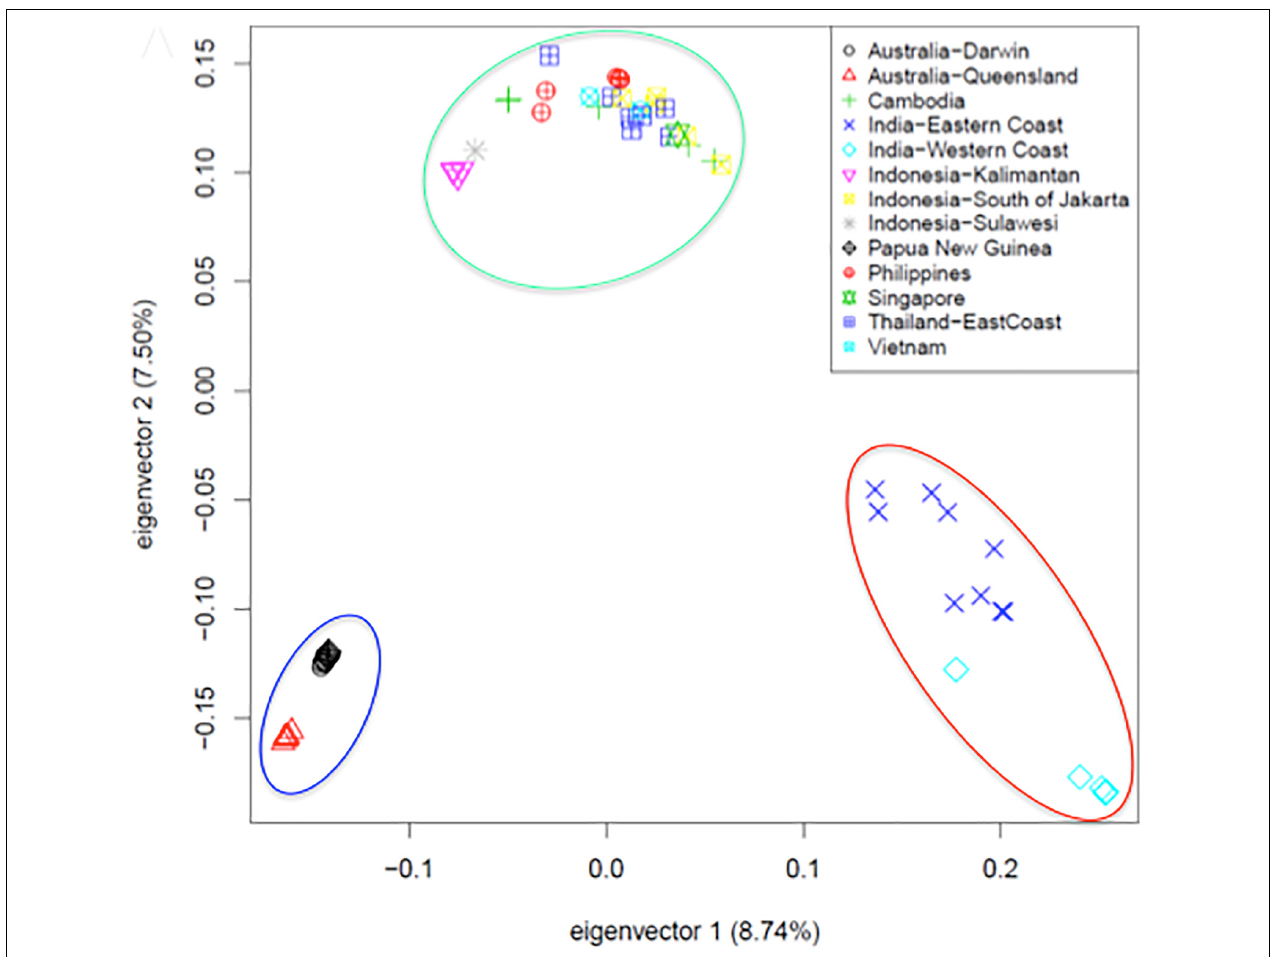
FIGURE 2 | Principal component analysis of SNPs collected from 61 re-sequenced genomes supports the existence of a Asian seabass species complex and its separation into two species and a third variety [adapted from Figure 5A of Vij et al. (2016) with the authors’ permission]. Fin clip samples were collected from twelve geographical locations representing the native range of the species extending from North-Western India, through South-East Asia to North-Eastern Australia and sequenced to an average 6.7-fold coverage by Illumina short read technology. Three groups (Indian region – red ellipse, SE Asia/Philippines – green, and Australia/Papua New Guinea – blue) bearing clear allopatric signatures of separation could be observed through Principal Component Analysis. With the exception of Philippines, Vietnam and Singapore, all individuals from the remaining locations were